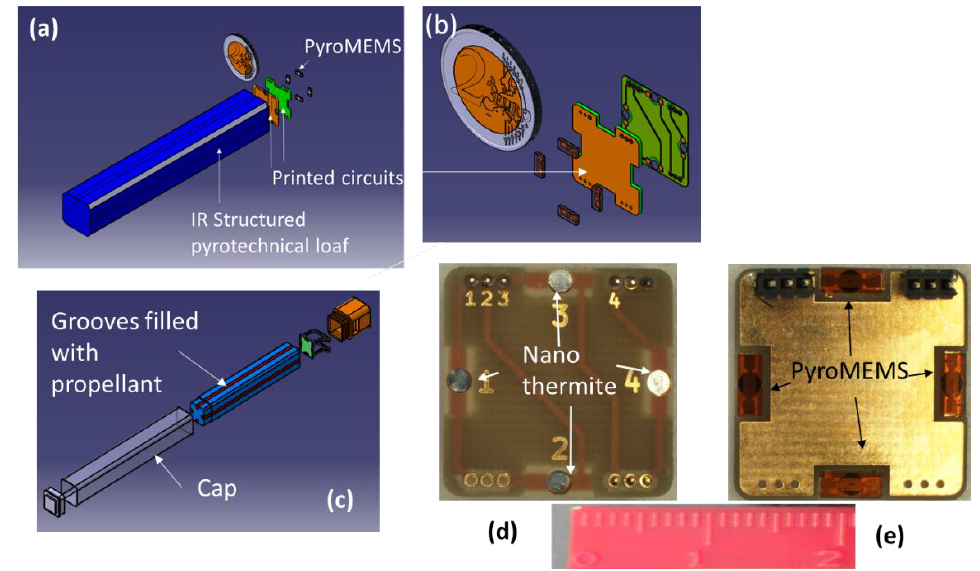
Figure 4. ( a ) Schematic of the IR loaf comprising 4 grooves (blue) filled with IR pyrotechnical charges that can be ignited using the 5 × 2.2 mm pyroMEMS mounted on the PCBs (green). ( b ) Enlarged view of the microinitiation stage comprising 4 addressable pyroMEMS mounted on the PCBs. ( c ) Enlarged view of the pyrotechnical loaf components. ( d ) Photo of the front side of the PCB, which is in contact with the IR loaf, where the nanothermites can be distinguished. ( e ) Photo of the back side of the PCB, where the pyroMEMS can be distinguished.